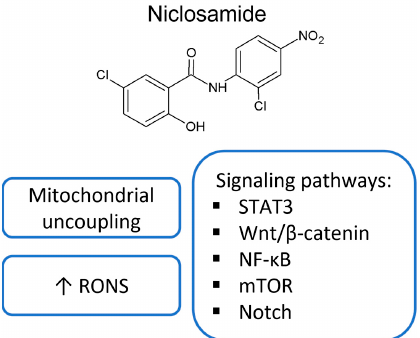
Figure 2. Summary of the most frequently proposed mechanisms of niclosamide’s anticancer effect. RONS, reactive oxide and nitrogen species. Table 1. List of studies focused on anticancer properties, including proposed mechanism of action and detailed effects of salicylanilide compounds closantel, oxyclozanide, rafoxanide, IMD-0354,